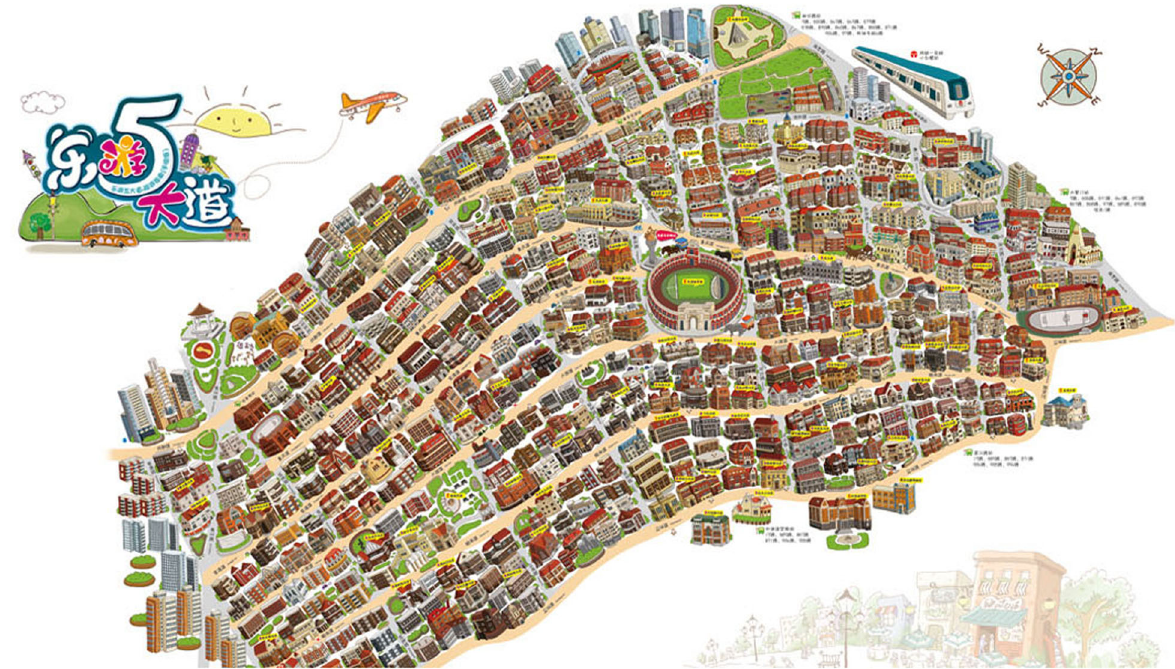
Fig. 11 Tourist map of Wudadao published in Tianjin (Source: Tianjin Tourism Bureau,